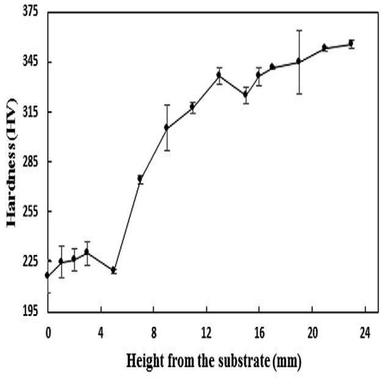
Micro-hardness distribution along deposited direction.